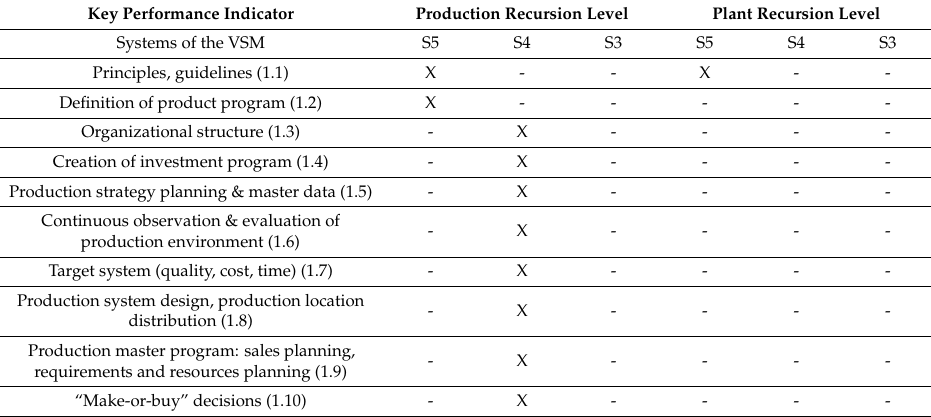
Table 1. Strategic production management tasks and its classification to VSM systems (own elaboration).